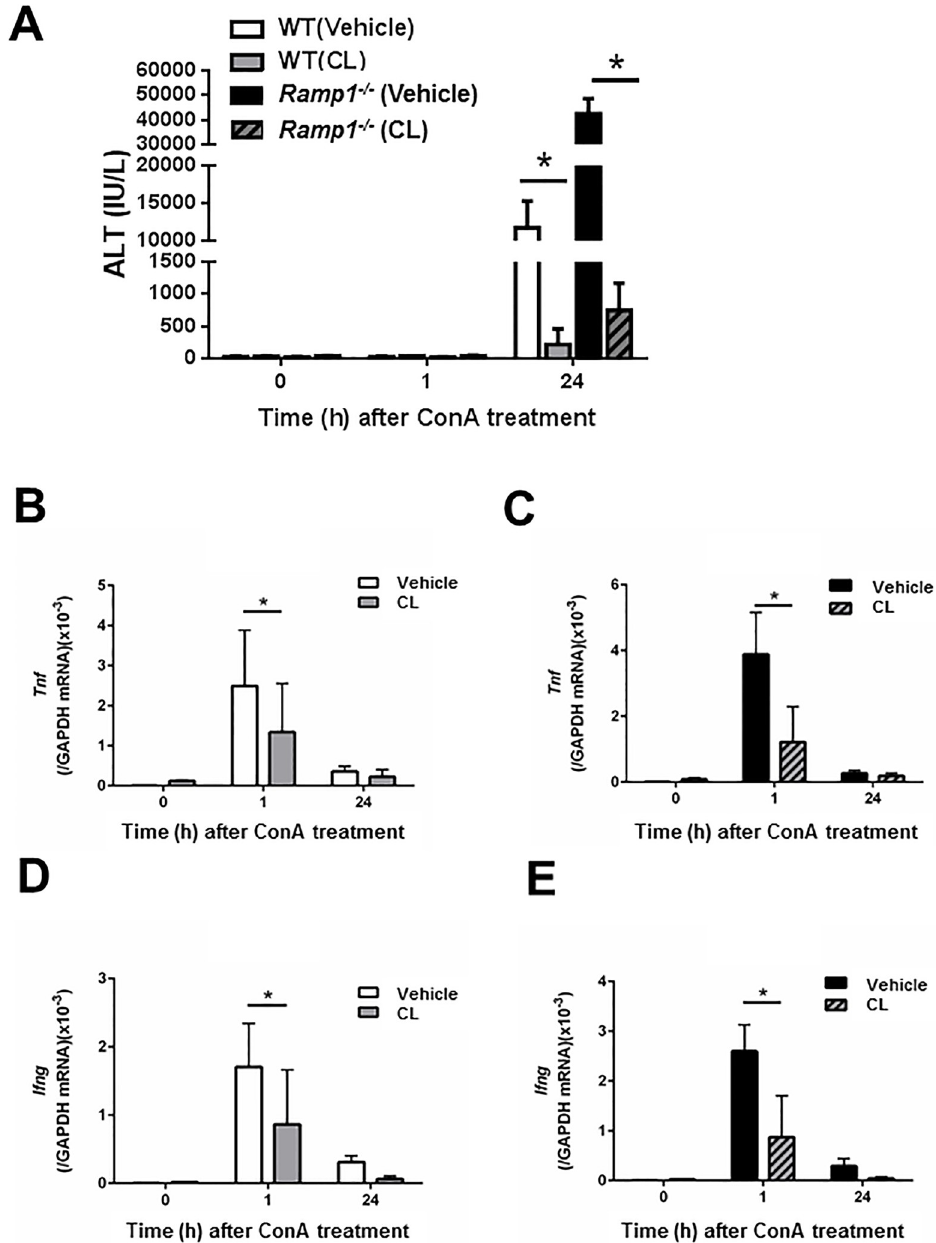
Fig 5. Deleting macrophages attenuates ConA-induced liver injury and decreases production of pro- inflammatory cytokines. (A) ALT levels in WT mice and Ramp1 -/- mice treated with clodronate liposomes (CL). Mice were treated with CL or vehicle (PBS) 48 h before ConA administration. Data are expressed as the mean ± SD from 3–6 mice per group. � p < 0.05. (B-E) Amounts of Tnf mRNA in WT mice (B) and Ramp1 -/- mice (C) treated with CL, and amounts of Ifng mRNA in WT mice (D) and Ramp1 -/- mice (E) treated with CL. Data are expressed as the mean ± SD from 3–6 mice per group. � p < 0.05.